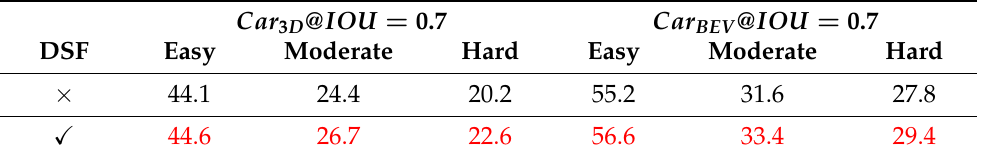
Table 8. Ablation study on distance-sensitive factor with the “car” category of the KITTI valida- tion